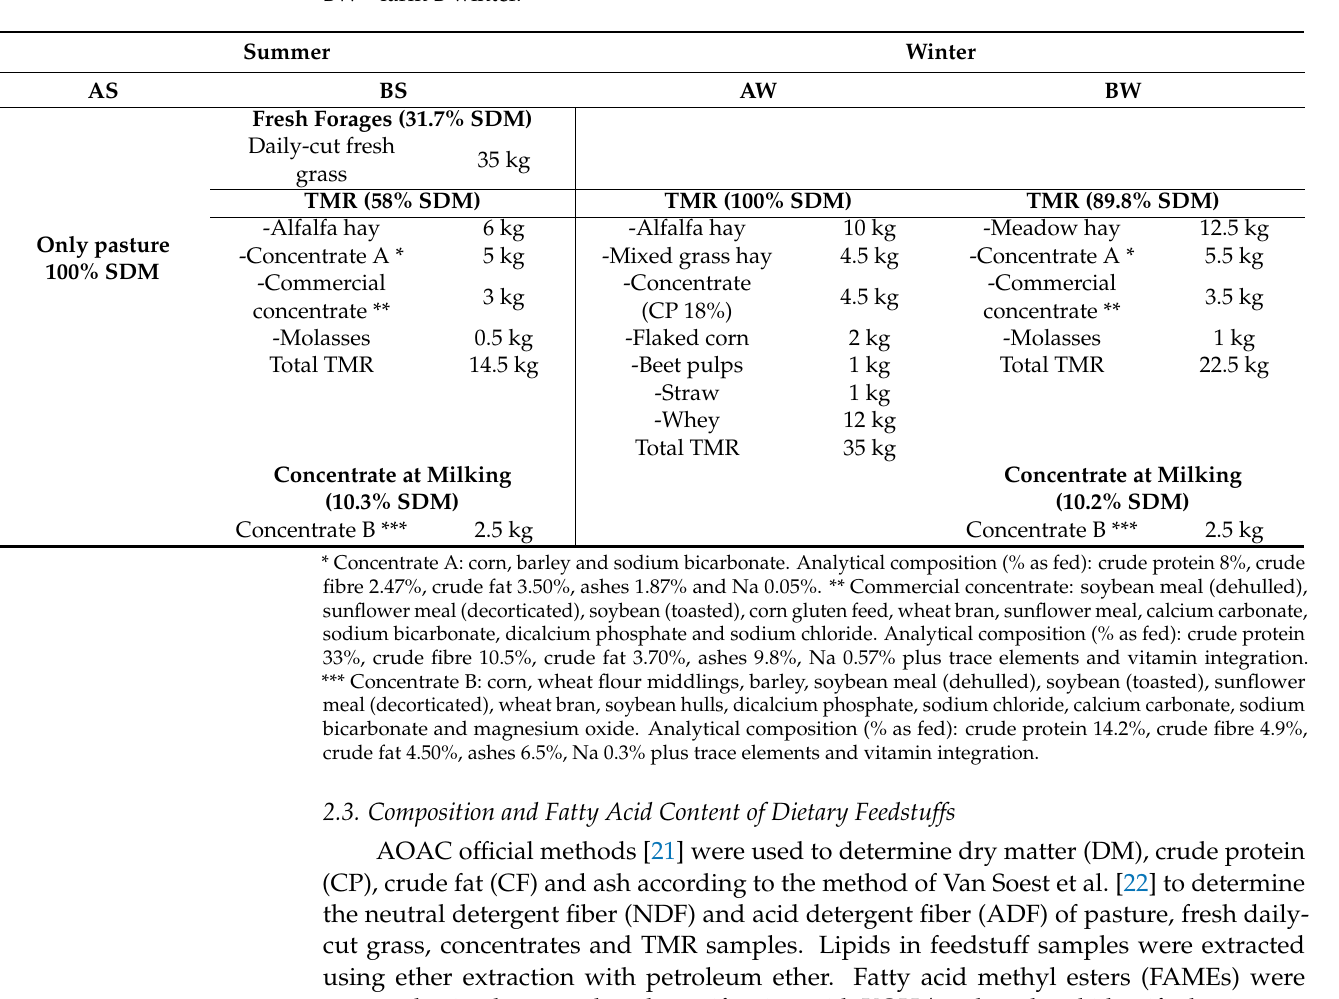
Table 1. Compositions of the winter and summer diets in the two farms involved in the study. Each ingredient is expressed as kg/head per day on an as-fed basis. The components of the diets (fresh grass, concentrate, total mixed ration, TMR), in bold, are presented as a percentage of